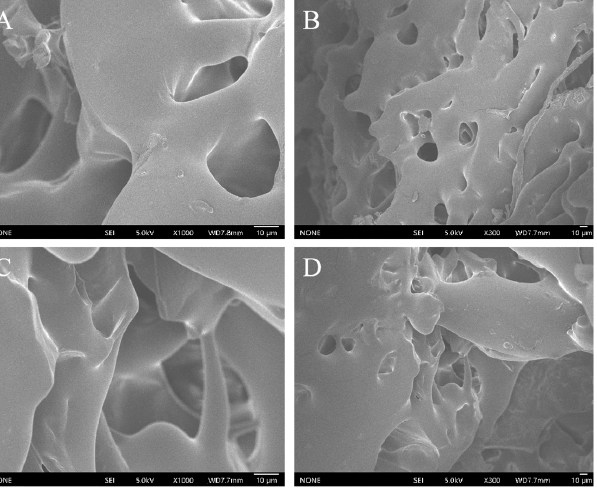
Figure 6. SEM micrographs of jelly added U-SDF (( A ): ×1000 magni fi cation; ( B ): ×300 magni fi cation) and jelly added M-SDF ( C ): ×1000 magni fi cation; ( D ): ×300 magni fi cation).